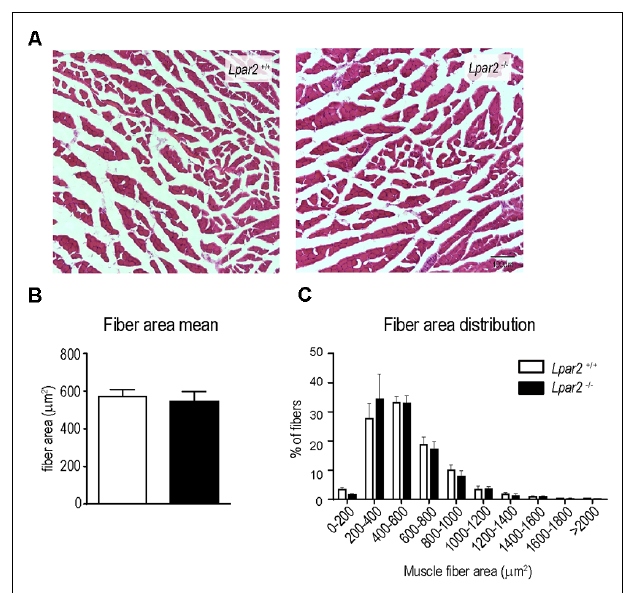
FIGURE 9 | Lpar2 deficiency does not prevent muscle atrophy after sciatic nerve injury. (A) Representative images of gastrocnemius muscle cross tissue sections at 21 days after sciatic nerve transection. (B,C) Plot showing the quantification of the muscle cross-section area (B) and the distribution of muscle fiber width (C) . Lpar2 − / − mice ( n = 4) Lpar2 +/+ mice ( n = 6). Unpaired t -student in (B) ; Two-way RM ANOVA with Bonferroni’s post hoc test in (C) . Data shown as mean ±